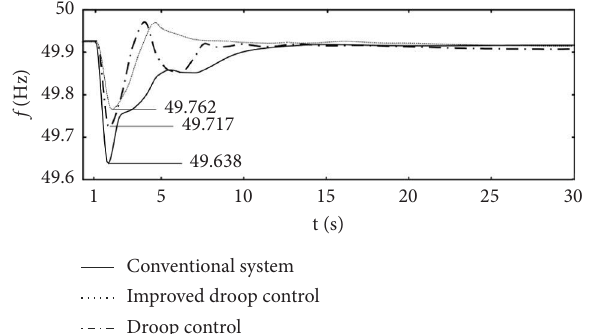
Figure 10: System frequency response for improved droop